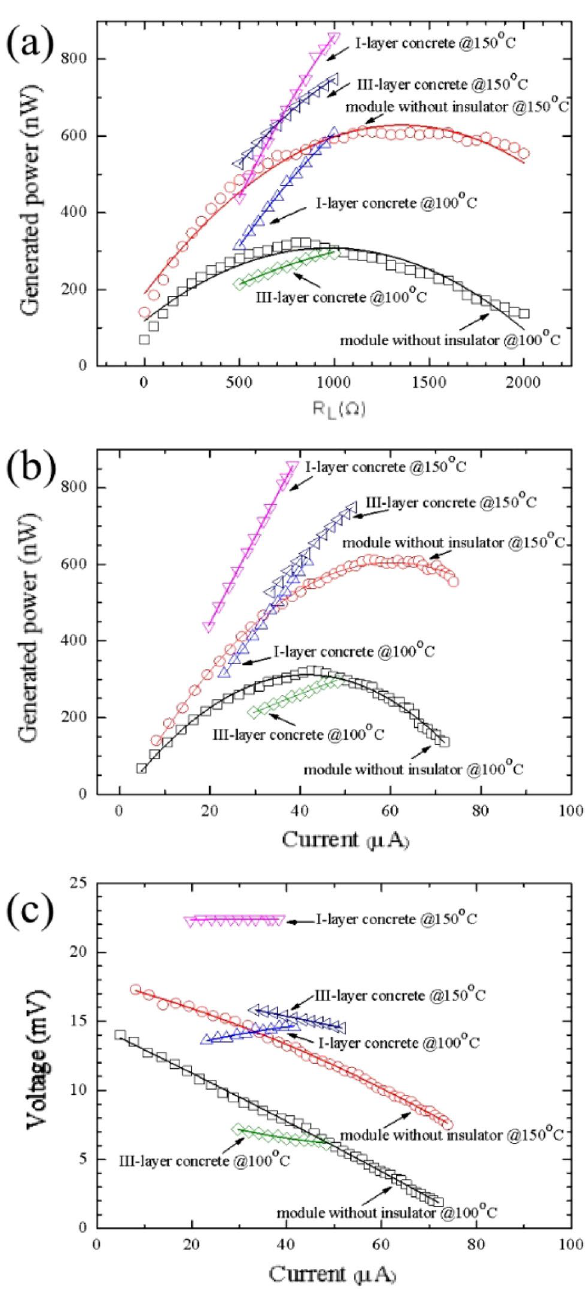
Figure 13. ( a ) Output power as a function of load resistance, ( b ) output power as a function of electric current, ( c ) output voltage as a function of electric current of the TEG module without an insulator, the I-layer brick and the III-layer